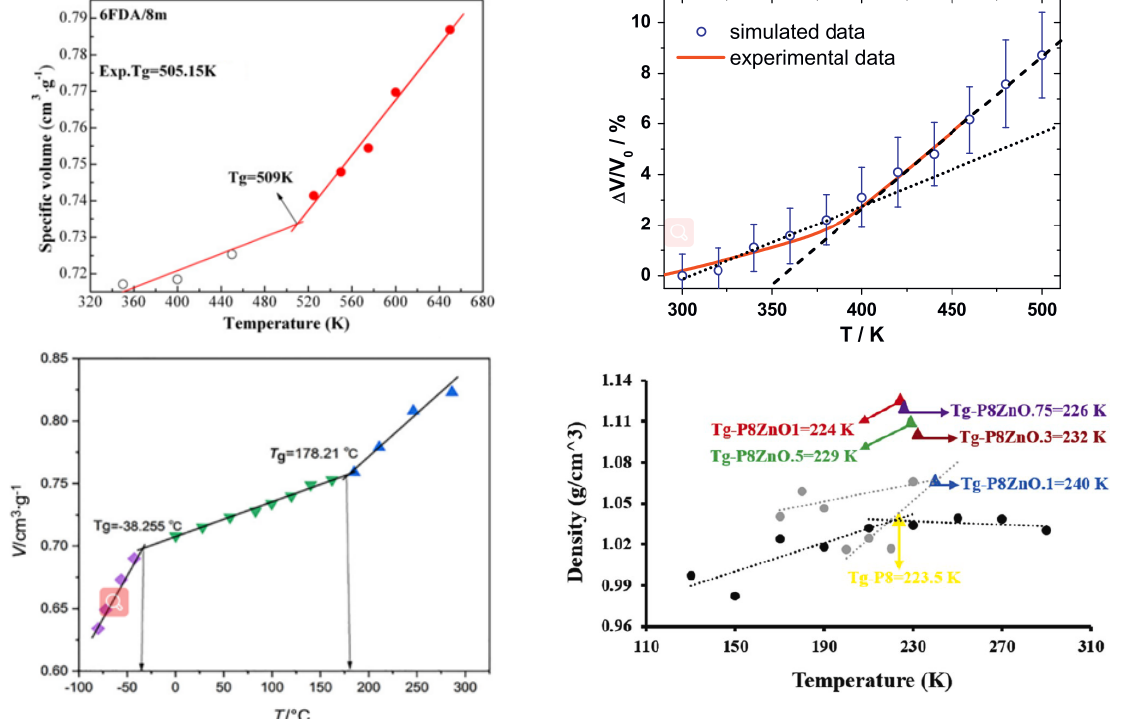
Figure 11. Specific volume versus temperature for composite membranes [51,52,56,62].